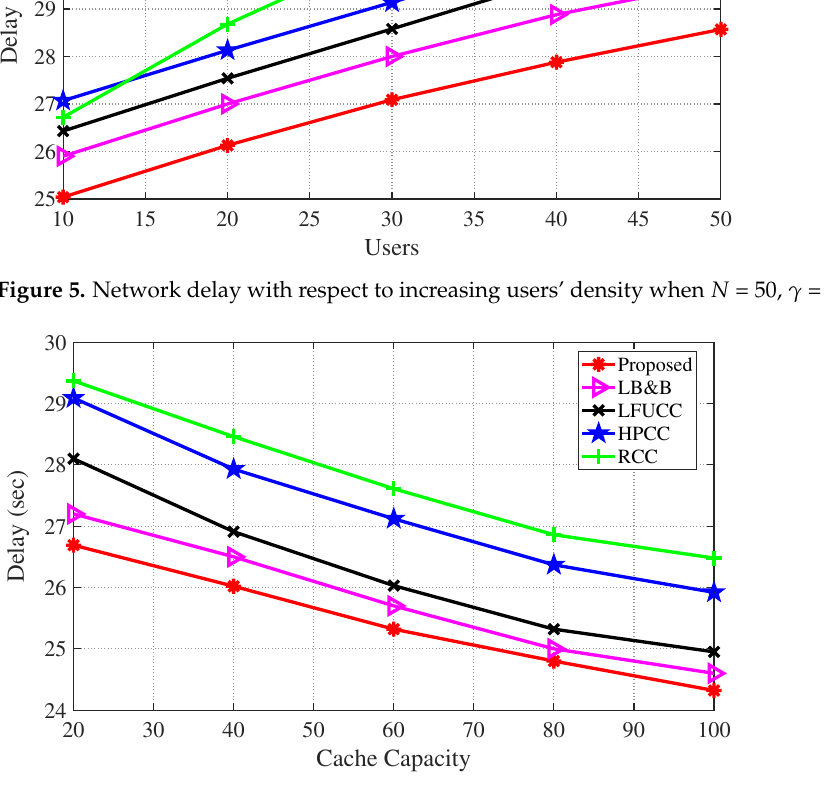
Figure 6. Impact of increasing cache capacity on network delay when N = 50, F = 400, and γ =